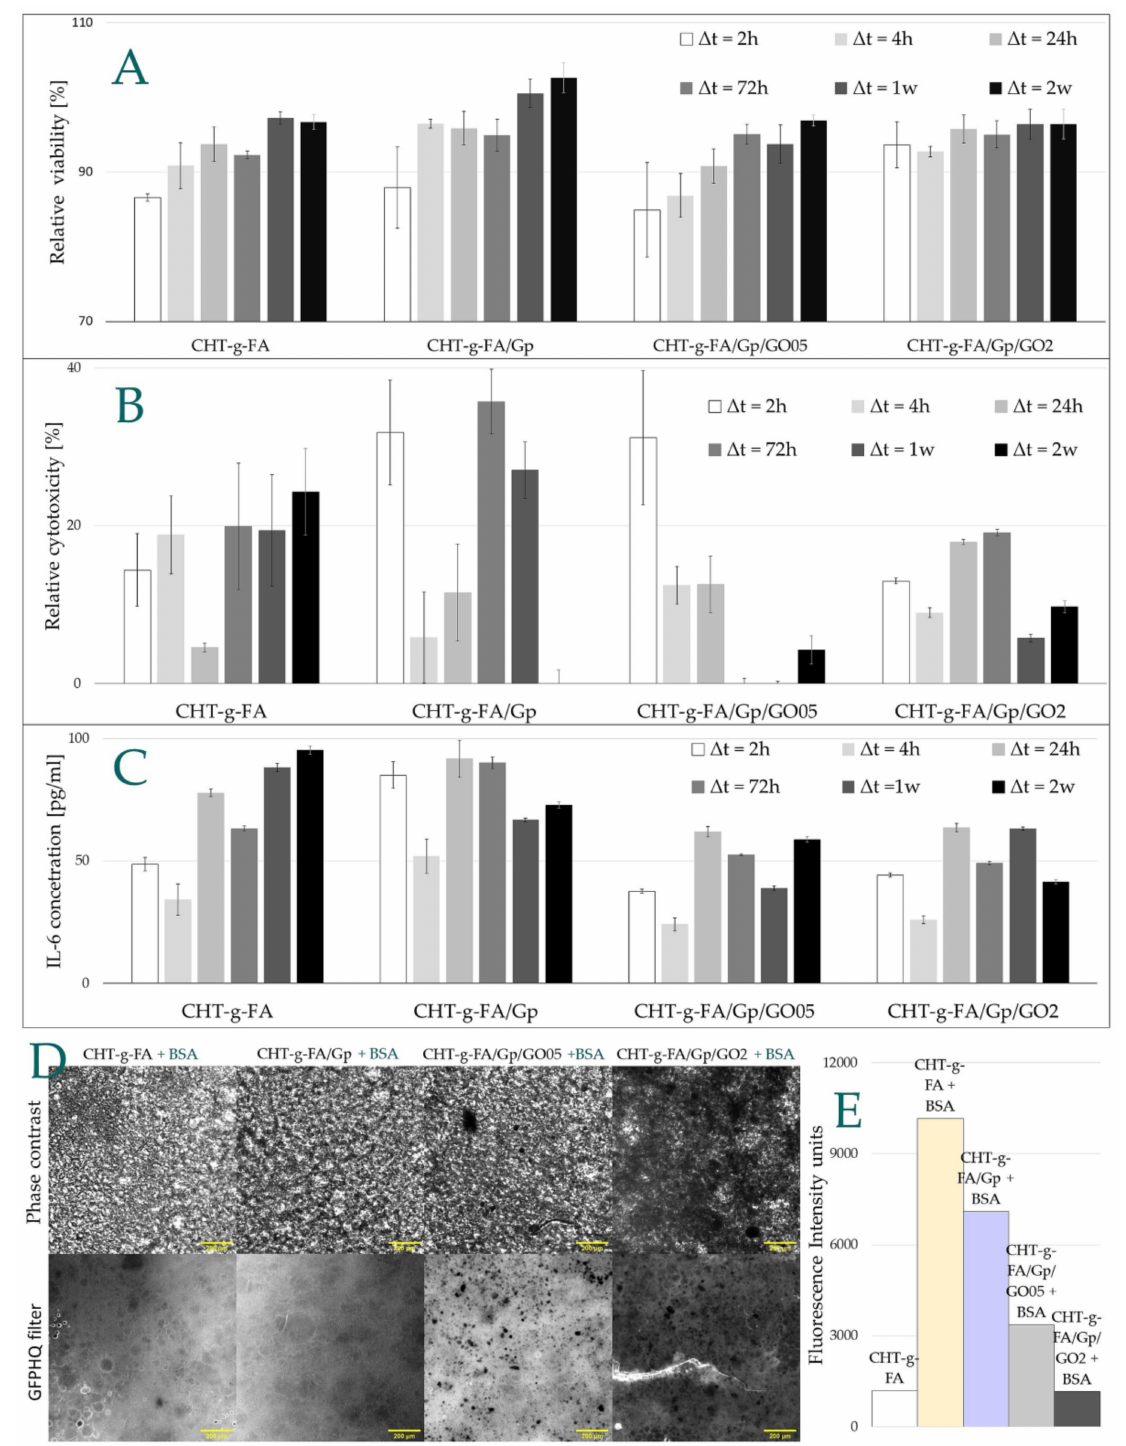
Figure 8. ( A ) Relative viability according to MTT measurements; ( B ) relative cytotoxicity calculated from LDH investigation; ( C ) IL-6 expression measured by ELISA assay; ( D ) microscopy images of chitosan-FA copolymer after incubation in BSA solution whereby the scale bar envelops 200 µ m; ( E ) fluorescence intensity of FITC-modified BSA adsorbed onto the chitosan derivatives surfaces. measurements due to its intrinsic quenching ability, as the fluorescence is diminished with the GO ratio to copolymer increase. Still, this composite copolymer can be a good candidate for applications where antifouling properties are